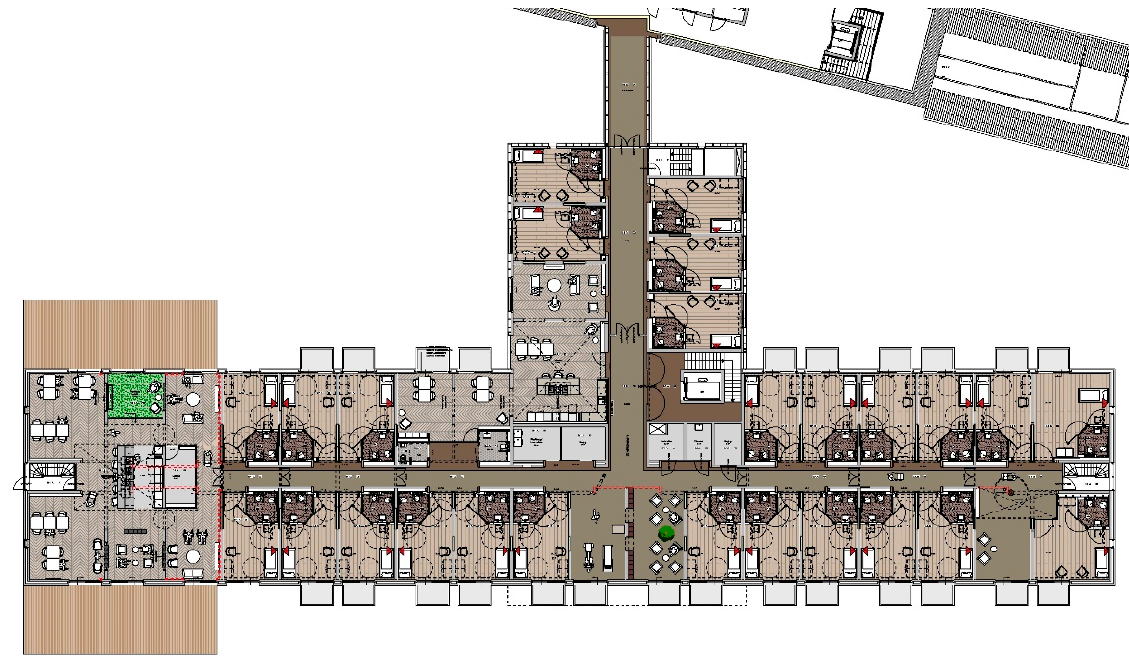
Figure 3. Floor plan of the Homestead (© Reproduced with permission from Widdershoven Architecten bv).